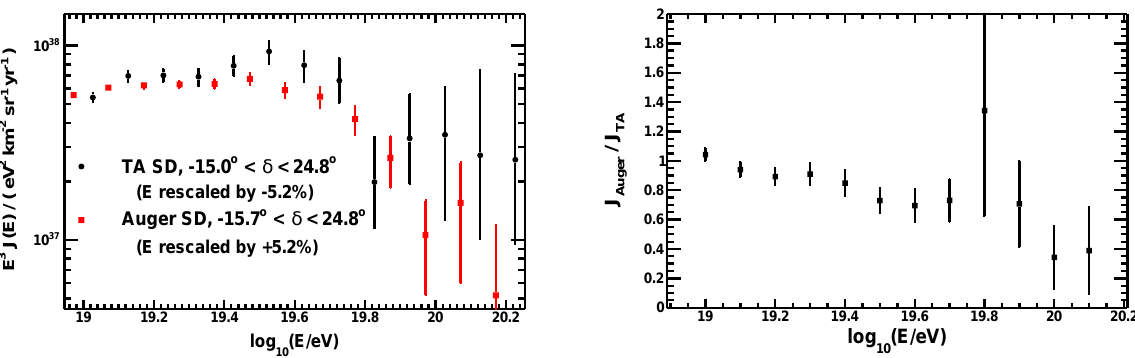
Figure 2. (left) TA and Auger spectra in the common declination band after applying overall + 5.2% (Auger) and -5.2% (TA) energy scale corrections. (right) Significant di ff erence between TA and Auger spectra persists even after rescaling the TA and Auger energies by the constant factors and restricting the comparison to the common declination band.